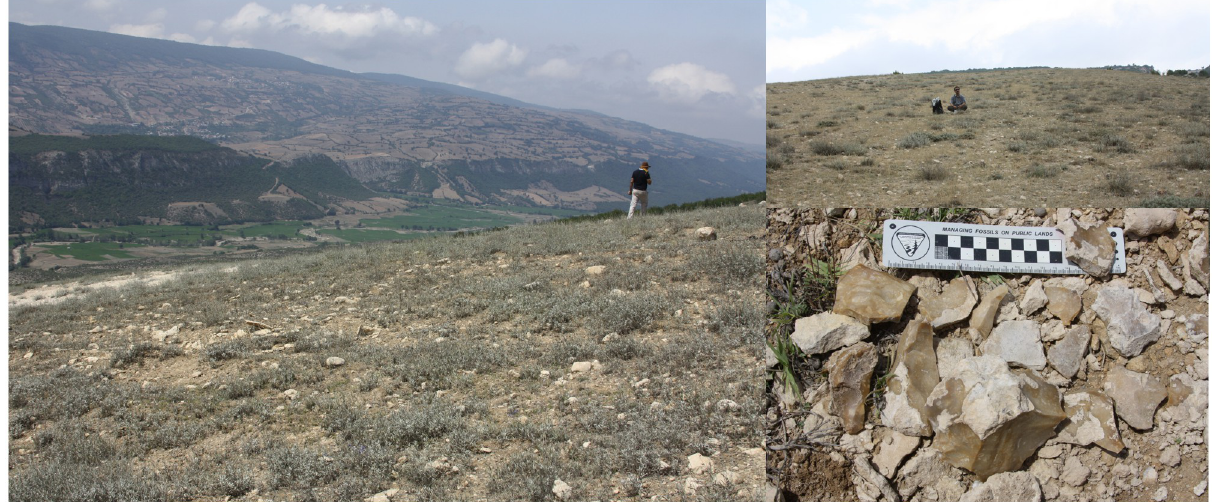
Fig 11. Wezwar open air site in eastern SCC (photos by E.